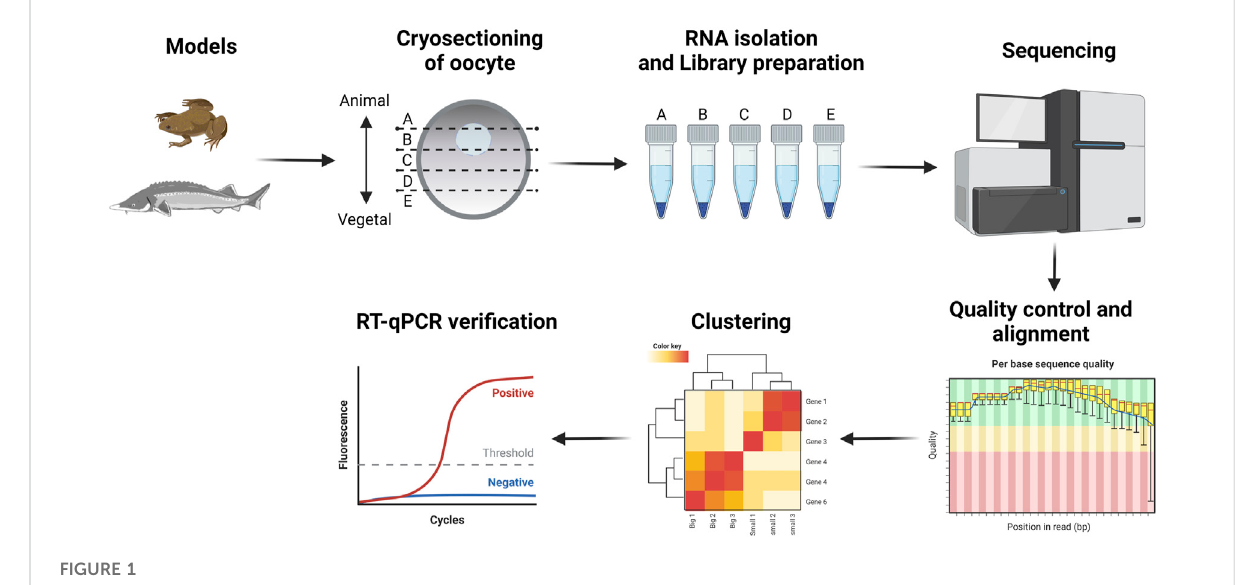
FIGURE 1 Schematic of the methodological work fl ow.